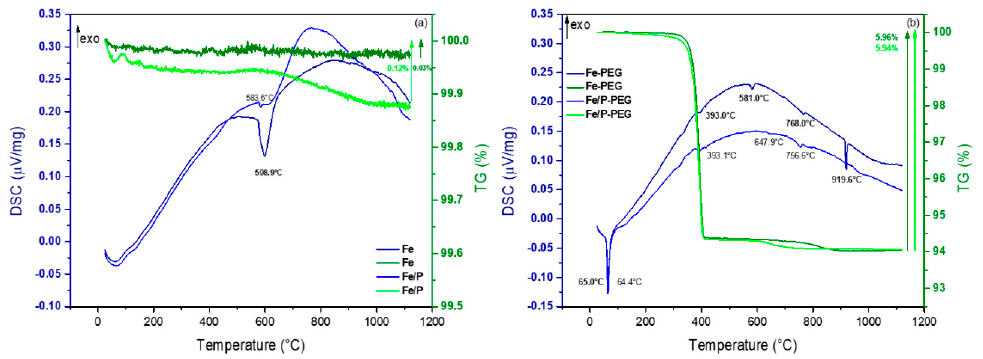
Figure 2. Di ff erential scanning calorimetry / thermogravimetry (DSC / TG) analysis of Fe and Fe / P foams Figure 2. Differential scanning calorimetry/thermogravimetry (DSC/TG) analysis of Fe and Fe/P without PEG ( a ) and with a PEG coating layer ( b foams without PEG ( a ) and with a PEG coating layer ( b ).